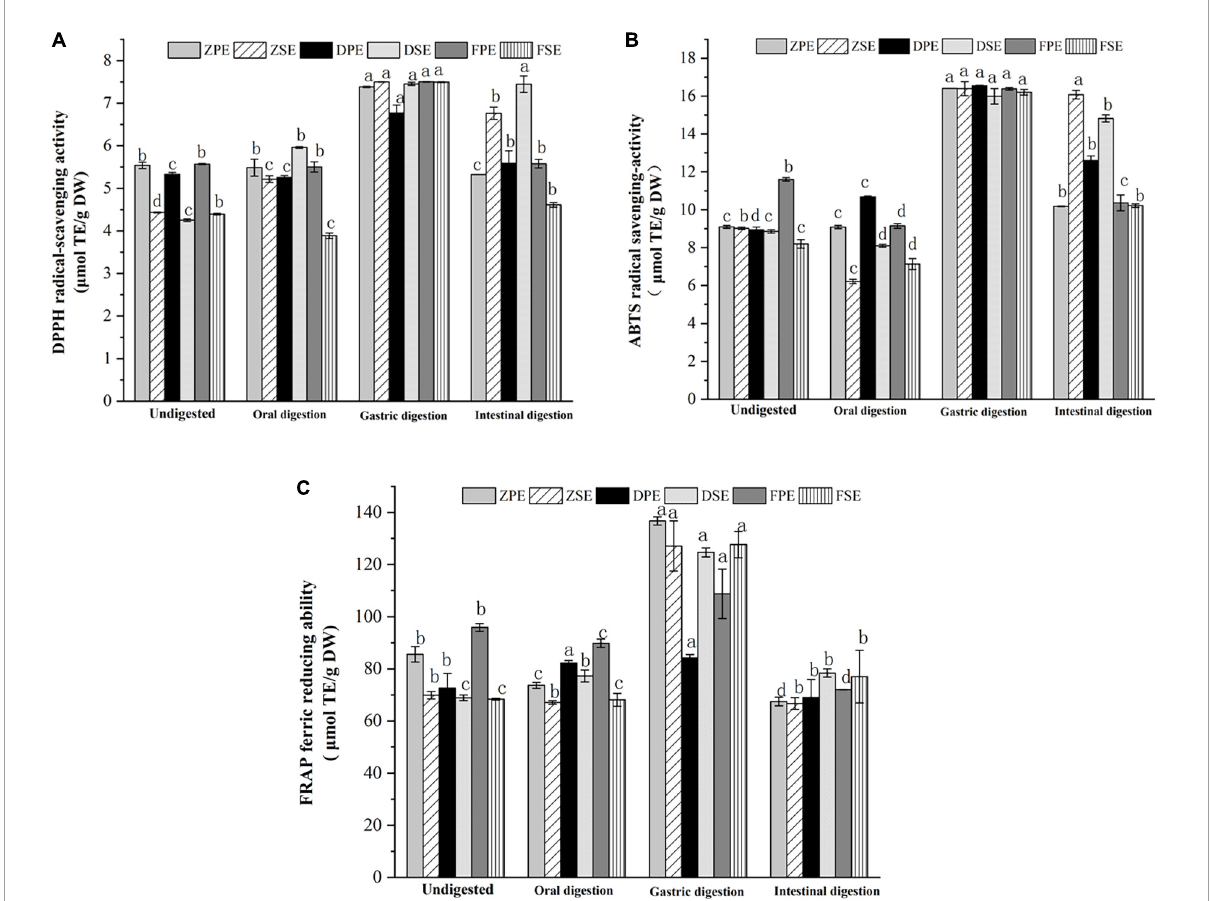
FIGURE3 Effects of antioxidant activity DPPH (A) ; ABTS (B) ; and FRAP (C) in simulated digestion of Kadsura coccinea . fruits. Values are presented as means ± SD ( n = 3), ( p < 0.05). ZPE, Zihei peel extract; DPE, Dahong peel extract; FPE, Fenhong peel extract; ZSE, Zihei sarcocarp extract, DSE, Dahong sarcocarp extract; FSE, Fenhong sarcocarp